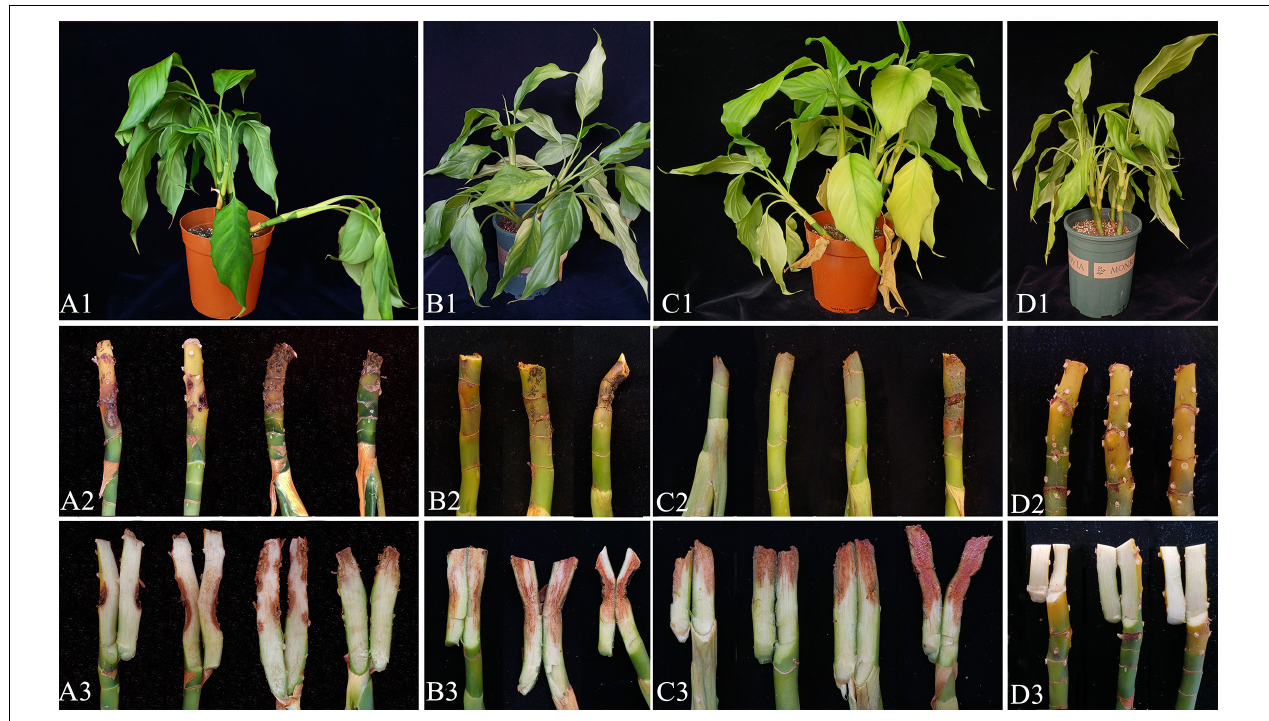
FIGURE 6 | Inoculation test results of Alocasia modestum stem rot ( A. modestum ). (A1–A3) Inoculation with F. elaeidis only. (B1–B3) Inoculation with F. aglaonematis only. (C1–C3) Inoculation with both F. elaeidis and F. aglaonematis. (D1–D3) Control plants of A. modestum after 15 days of inoculation.